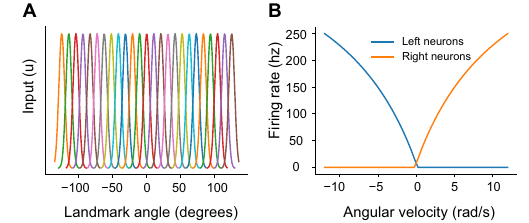
Figure 7. Model input encoding. ( A ) Receptive fields for each set of ring neurons over the field of view. ( B ) Angular velocity encoding in P-EN